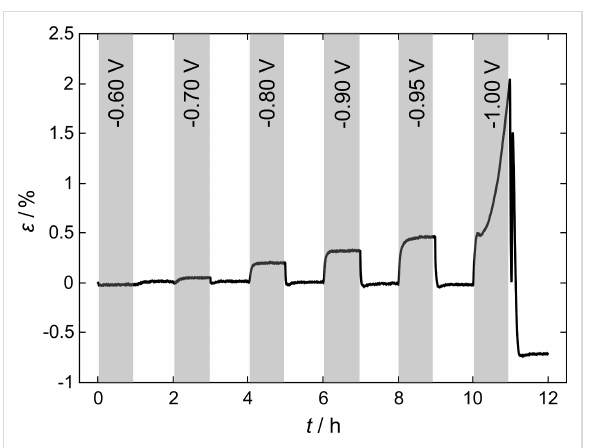
Figure 2: Strain ε as a function of the time t for a series of consecu- tive hydrogen absorption/desorption processes at constant potentials in 1 M KOH for nanoporous palladium. Loading processes are shaded grey, polarisation potentials are given in the grey bars, the unloading potential was fixed at − 0.4 V.